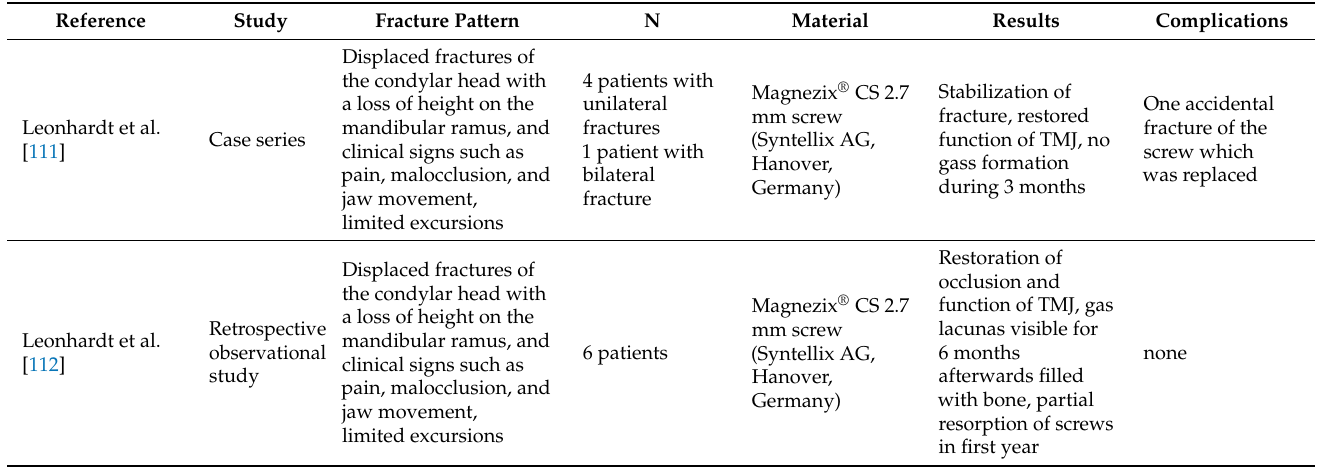
Table 2. Clinical studies on magnesium (Mg)-based material for stabilization of fracture of the mandibular